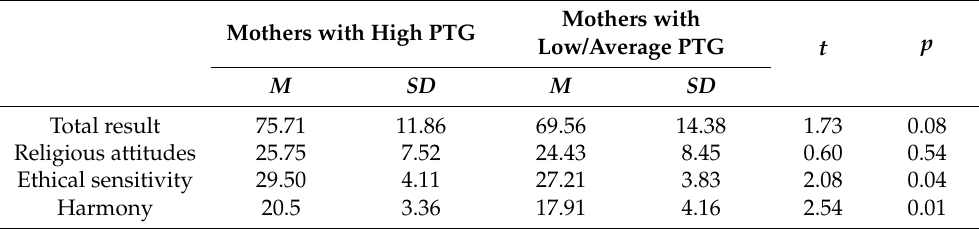
Table 4. Differences in